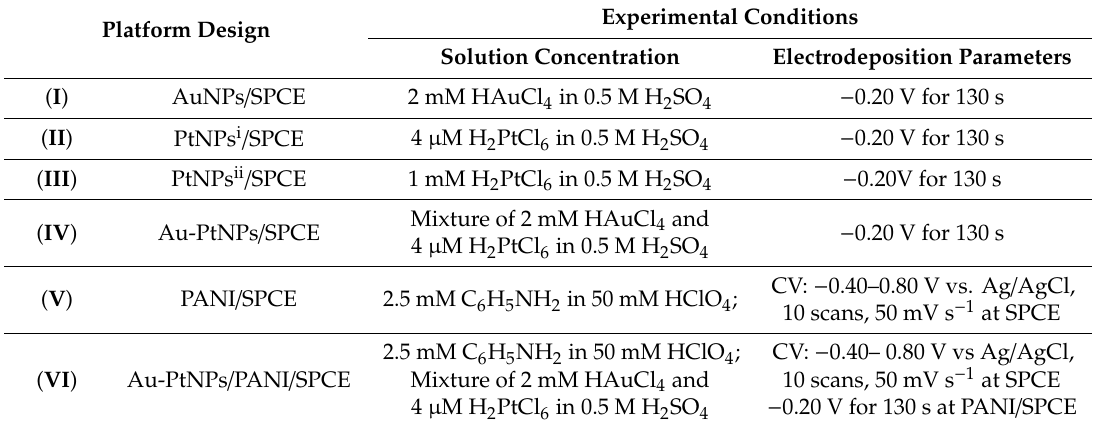
Table 1. Platform electrode configuration used in the